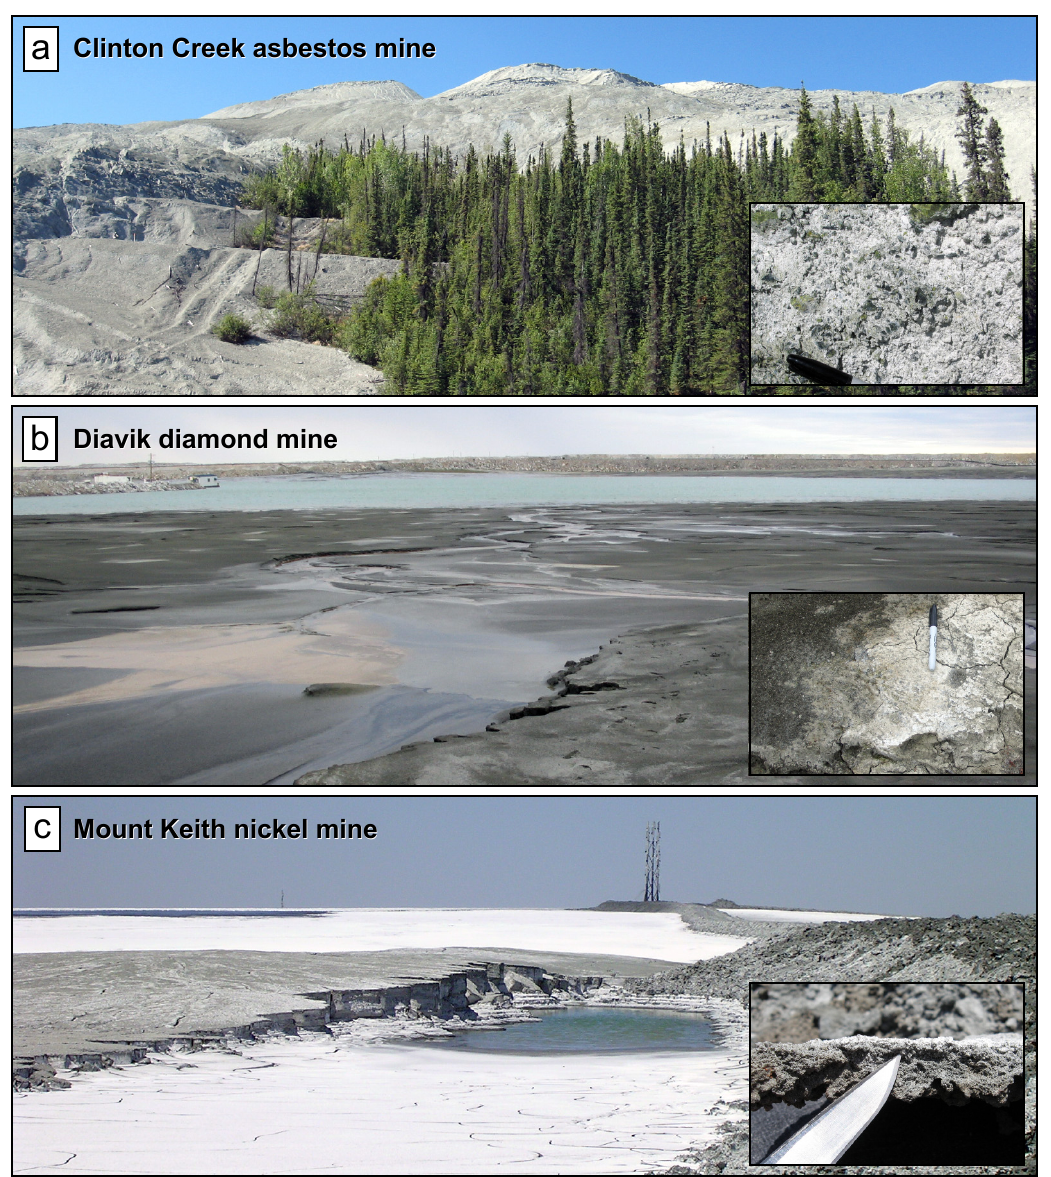
Figure 1. Tailings storage facilities (TSF) for ultramafic tailings. ( a ) Abandoned Clinton Creek asbestos mine in Yukon, Canada. Inset shows vertical efflorescent crust cementing chrysotile tailings (marker for scale). ( b ) Active Diavik diamond mine in Northwest Territories, Canada. Inset shows an efflorescent crust on surface of tailings (marker for scale). ( c ) Active Mount Keith nickel mine in Western Australia. Inset shows a surface efflorescent crust held up to show cross-sectional view (knife for scale). These carbonate crusts have formed from passive carbonation under normal mining